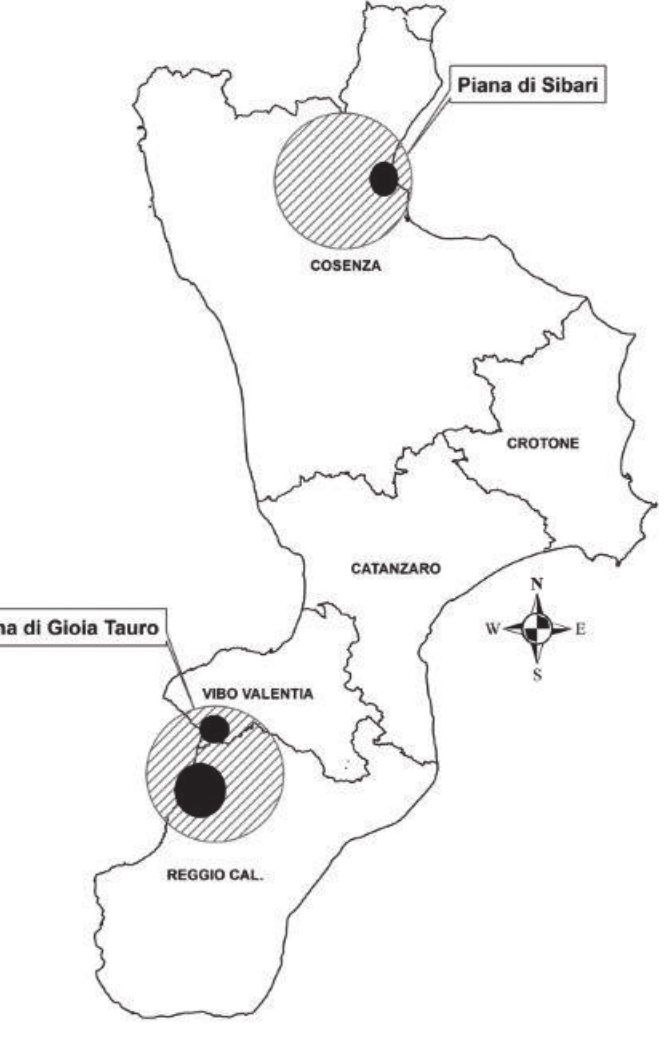
Figure 2. Citrus areas (black circles) where new outbreaks of Citrus tristeza virus (black spots) were